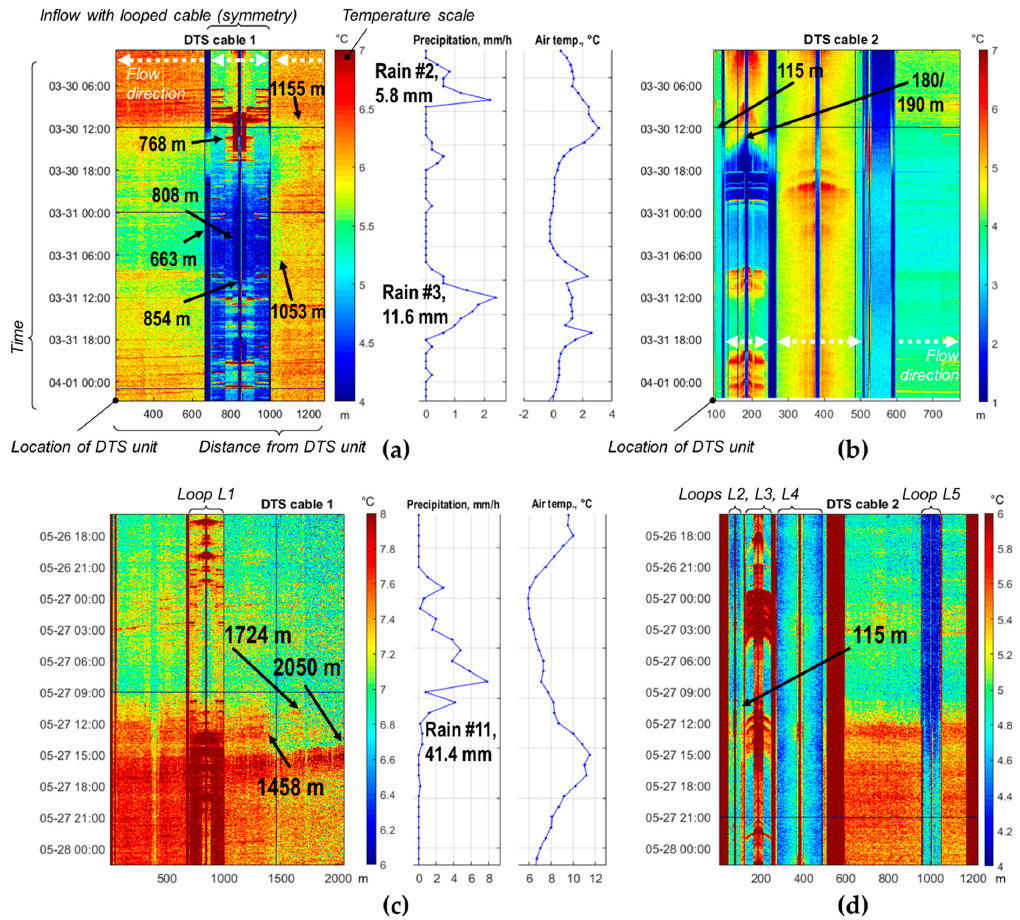
Figure 4. The DTS plot for cable 1 ( a , c ) and cable 2 ( b , d ) with identified temperature anomalies (solid line arrows) during rain events #2 and #3 ( a , b ) and #11 ( c , d ) visible. Note the difference in the temperature scales. Table 2. Summary of identified temperature anomalies (marked with plus sign) during rain-on-snow, snowmelt and rain events and their possible pathways (UI—upstream inflow) (discussed further in the discussion section). RGI / SGI—rainfall / snowmelt induced groundwater infiltration; SRI—snowmelt runo ff inflow; UI—upstream